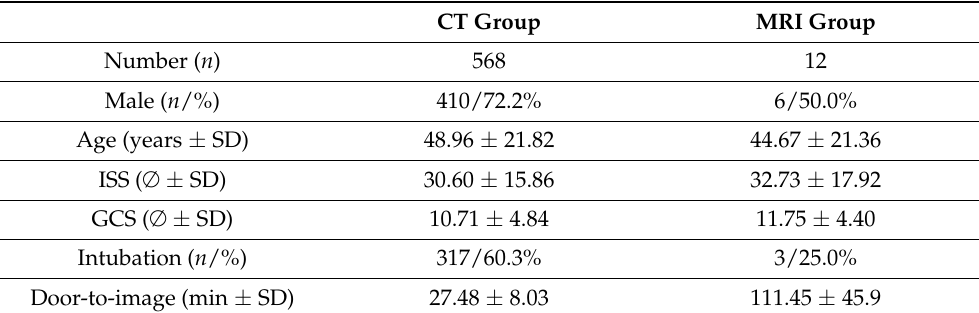
Table 1. Demographic data of analyzed patients. ISS—injury severity score, GCS—Glasgow Coma Scale, SD—standard